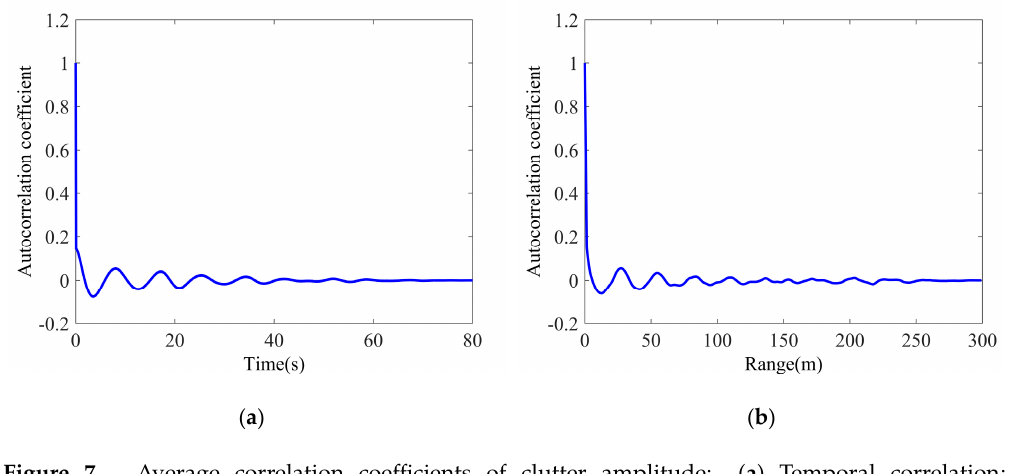
Figure 7. Average correlation coefficients of clutter amplitude: ( a ) Temporal correlation; ( b ) Spatial correlation.